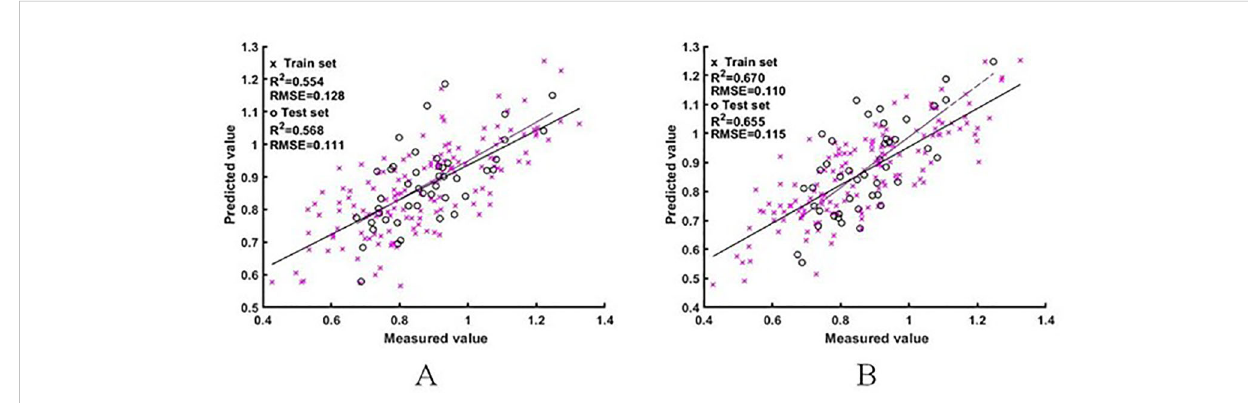
FIGURE 7 NNI estimation results based on difference spectra [ A for ELM model estimation result, (B) for BES-ELM model estimation result].